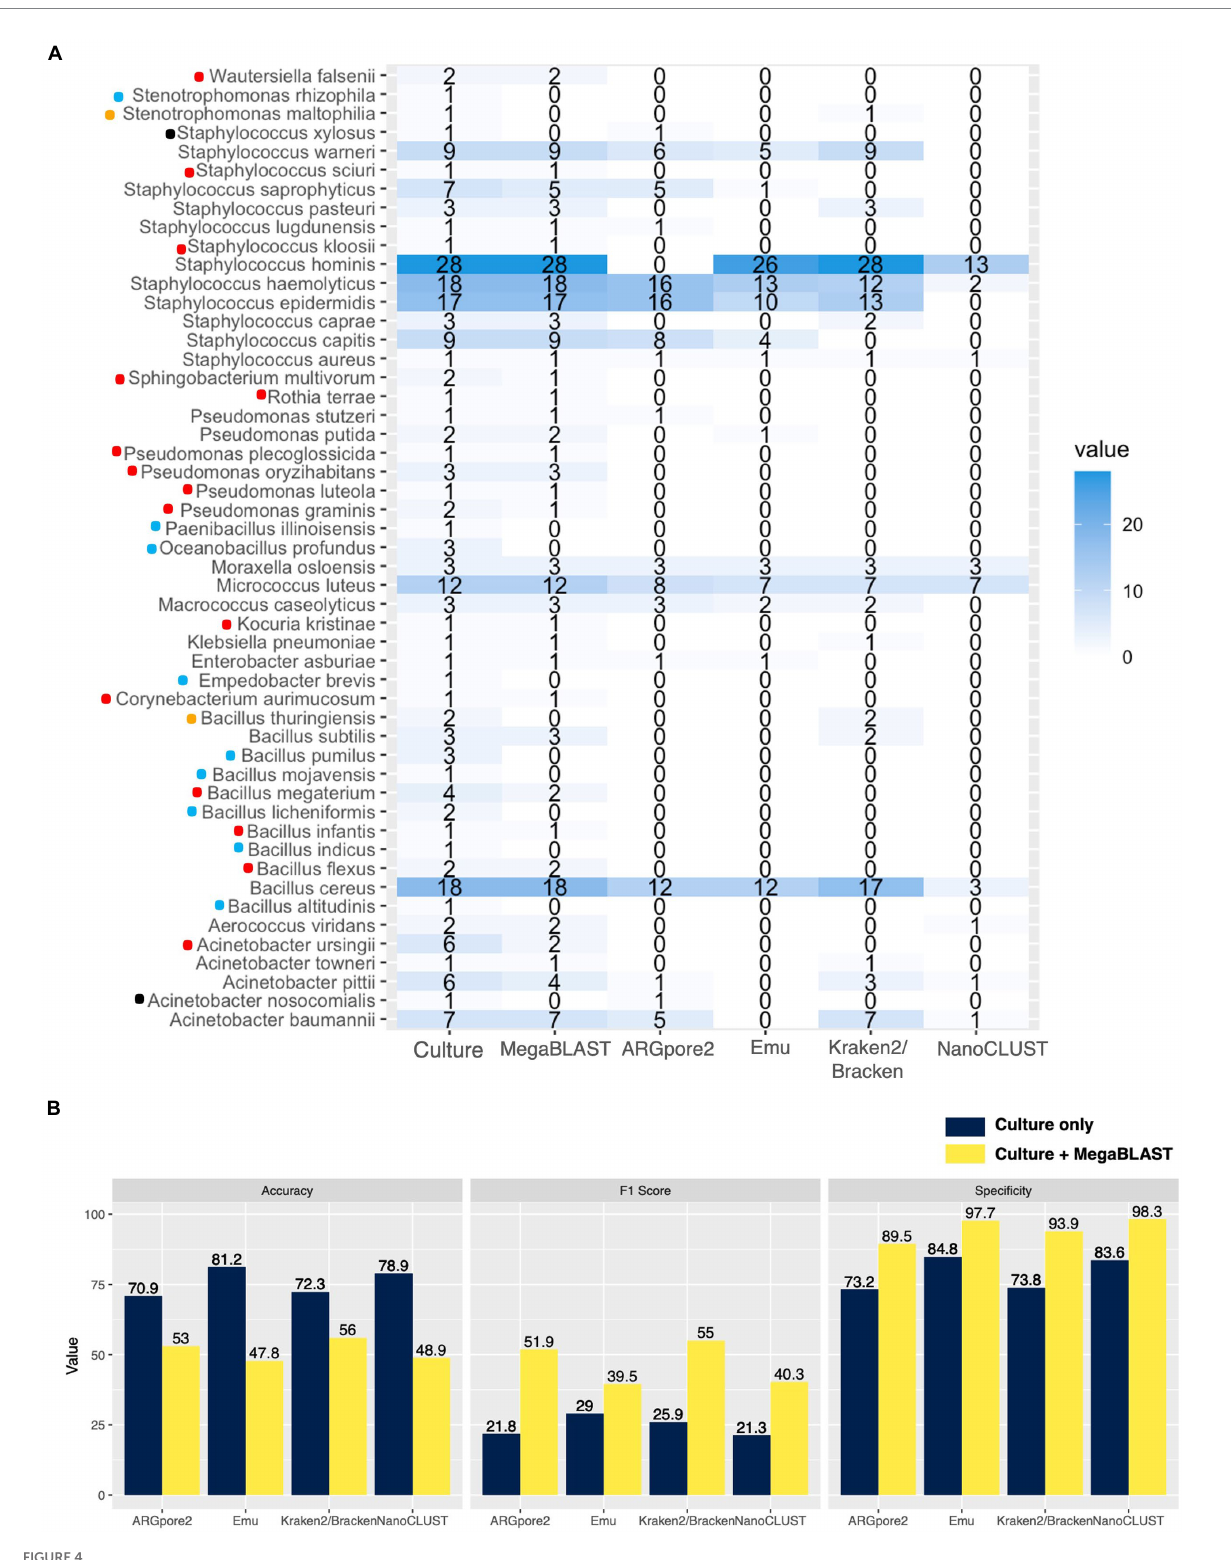
FIGURE 4 Concordance of the culturable species between MegaBLAST and the four classifiers. (A) Detectable and cultured species in the four classifiers. The value represents the number of urban samples with the corresponding bacterial species concordant with the culture results. Red dots indicate the detectable species in MegaBLAST, while blue dots represent the absence of the species in the sequencing data. Four species were not detected by MegaBLAST but could be identified by Kraken2/Bracken and ARGpore2, which were labeled with orange and black dots, respectively. (B) Average F1 score (%) and specificity (%) increased in the complement results of culture and MegaBLAST while accuracy (%)